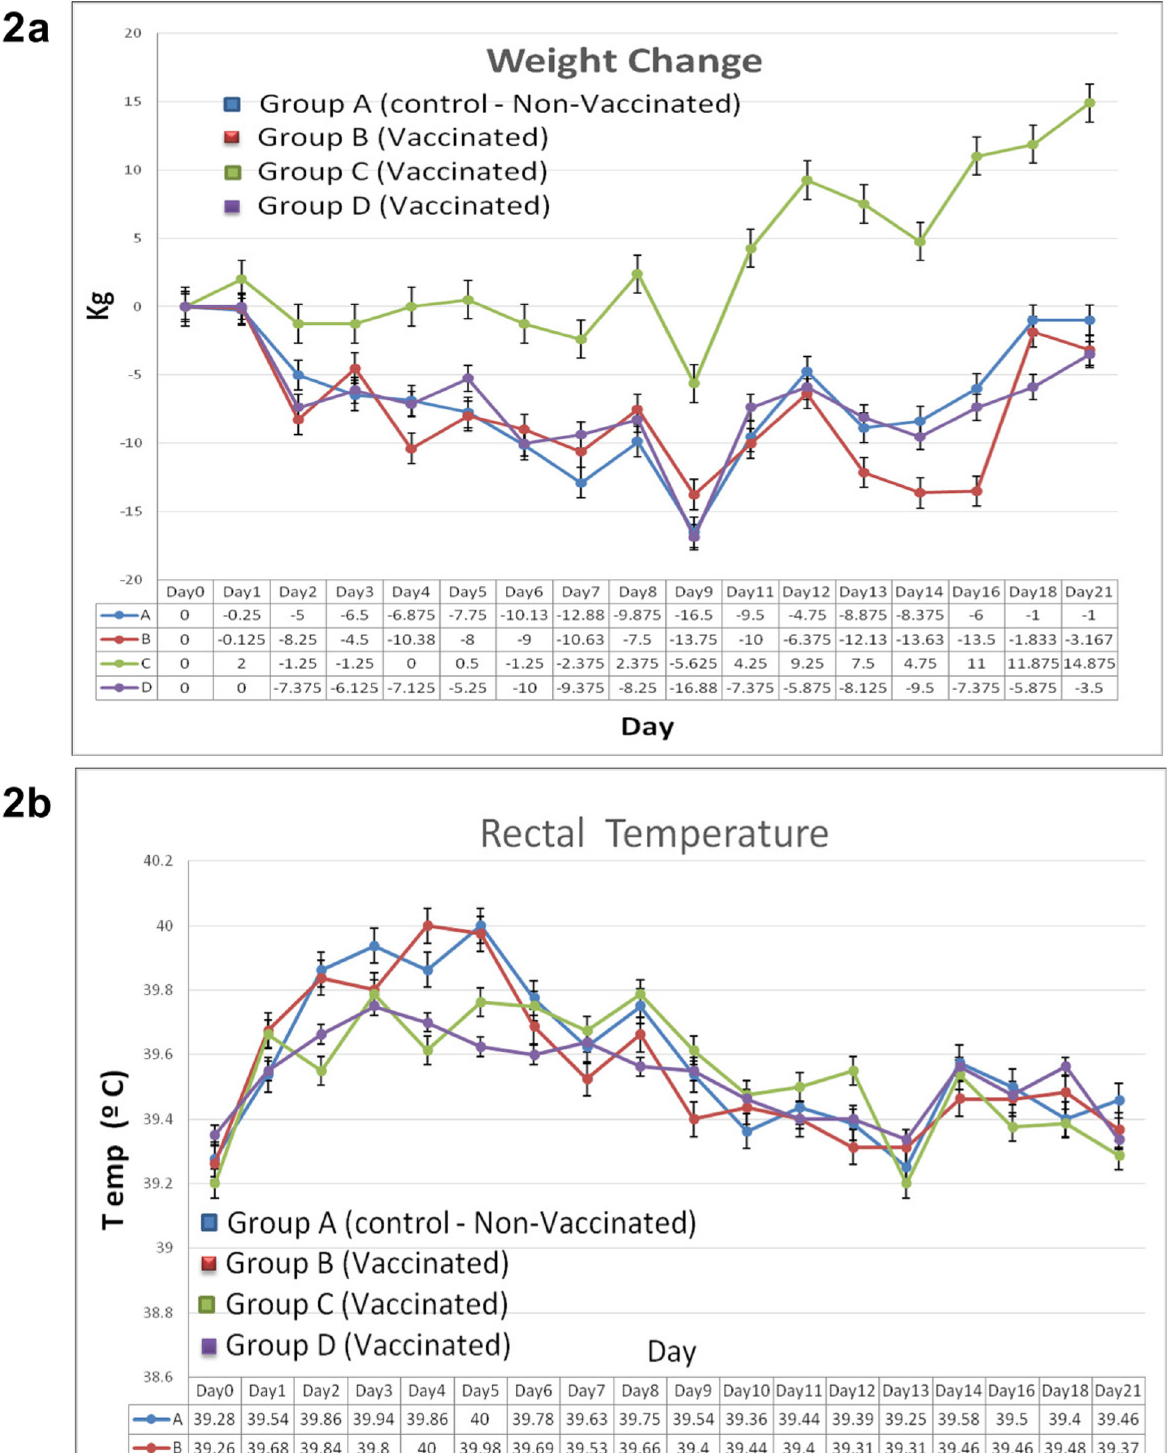
Fig 2. Weight and temperature change in response to infection with H . somni . ( 2a ) Weight change among group A (non vaccinated/ placebo group) and groups B, C and D (vaccinated) animals measured for 21 days post challenge. ( 2b ) Rectal temperature